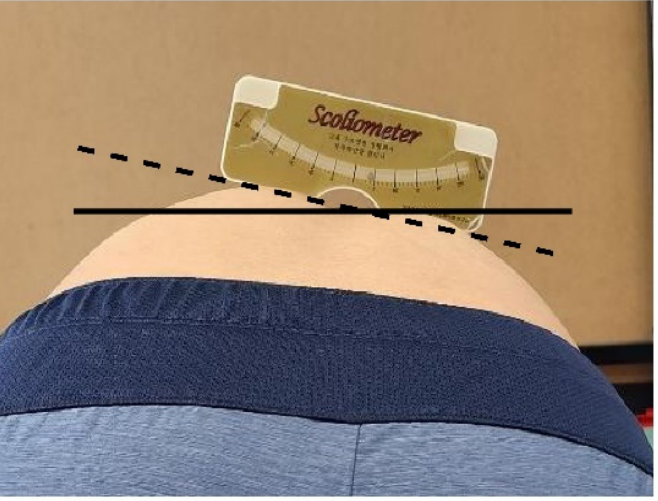
Figure 3. Scoliometer measurement.